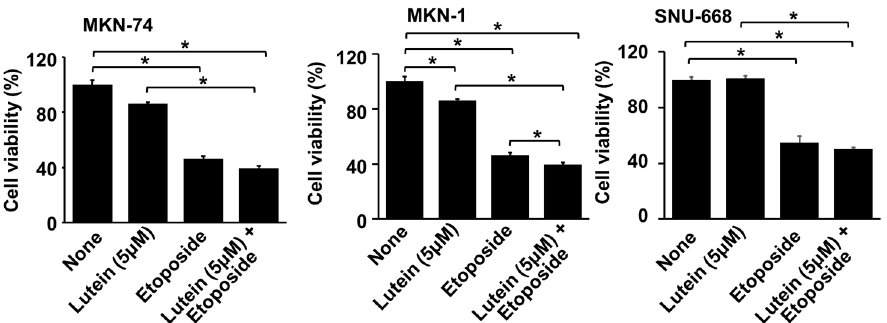
Figure 6. Effects of lutein on etoposide-induced cell death in MKN-74, MKN-1, and SNU-668 cells. The cells were pre-treated with 5 µ M lutein for 4 h and then treated with 10 µ M etoposide for 24 h. Cell viability was determined by counting the number of viable cells. The viability of untreated cells (“none”) was set at 100%. * p < 0.05.